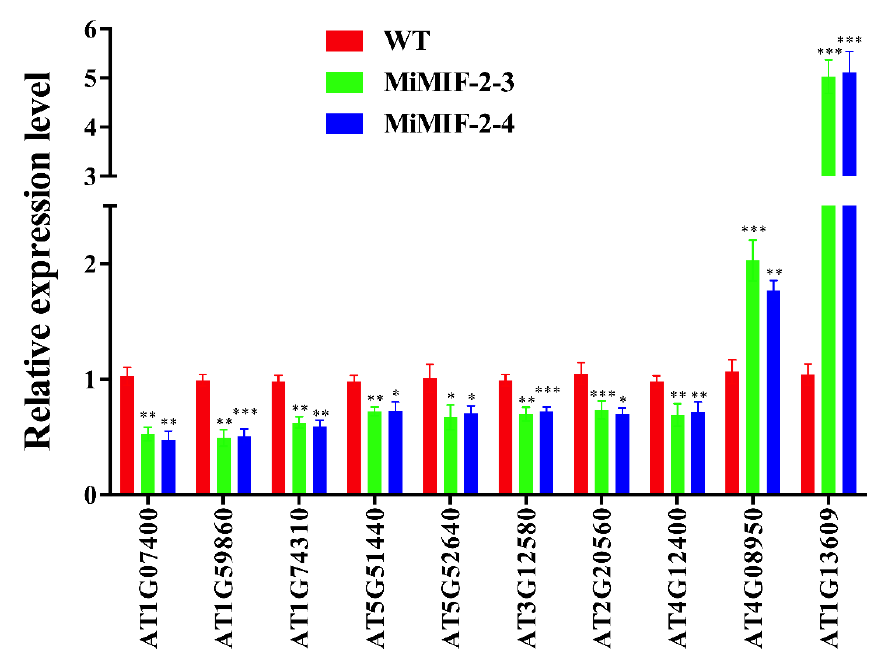
Figure 5. RT-qPCR verification of candidate differentially expressed genes (DEGs) between wild type and MiMIF-2 expressing Arabidopsis . The relative expression levels of 8 heat-shock-like proteins and 2 upregulated genes were analyzed by RT-qPCR and normalized using UBP22 ( AT5G10790 ) as the internal control. Data represent the mean fold-change ± SE. Mean values significantly different from wild type (*, **, ***) were determined by one-way ANOVA with Dunnett ′ s multiple comparisons test (Alpha 0.05). The experiment was repeated three times with similar results.